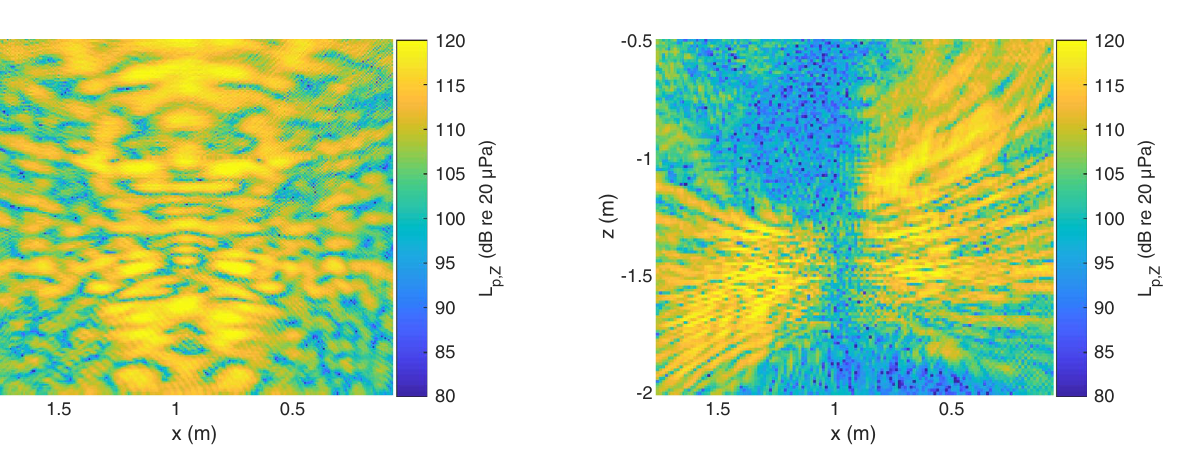
Figure 8. Z -weighted equivalent continuous sound pressure levels time-averaged over 0.64 s L p , Z ,eq 0.64 s of the one-third octave band with a center frequency of 20 kHz in a vertical plane 99 cm in front of the sonotrode ( S Figure 8 : y = (cid:1) 0.05 m) with a spatial resolution of 0.6 mm.